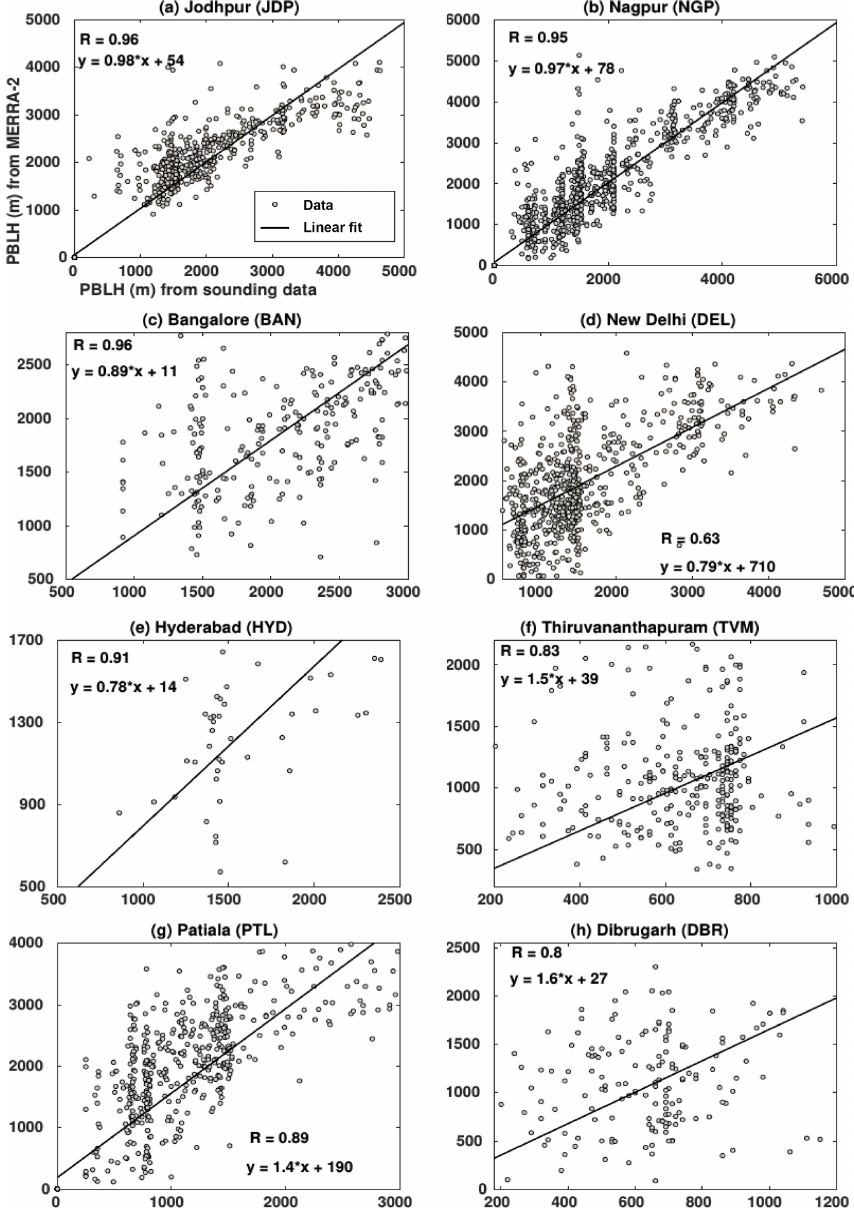
Figure 3. Comparison of spatiotemporally collocated MERRA-2 PBLHs with those derived from radiosonde measurements performed at eight representative locations during 2008 to 2018. The correlation coefficient ( R ) (significant at 95% confidence limit) and the equation of linear regression between the two PBLH estimates are provided in each of the